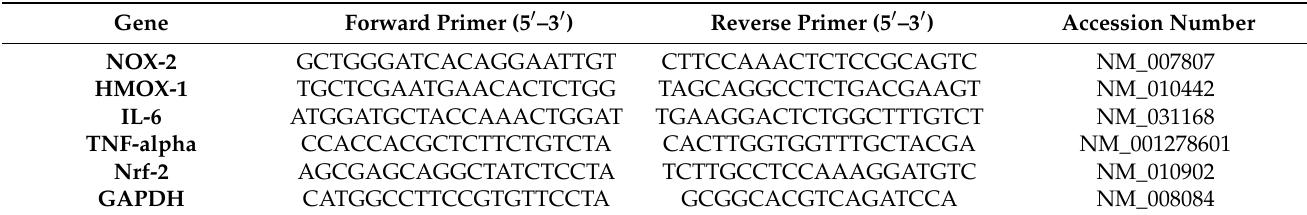
Table 2. Primers used in this study. Annealing temperature was 60 ◦ C for all transcripts. Gene Forward Primer (5 (cid:48) –3 (cid:48)